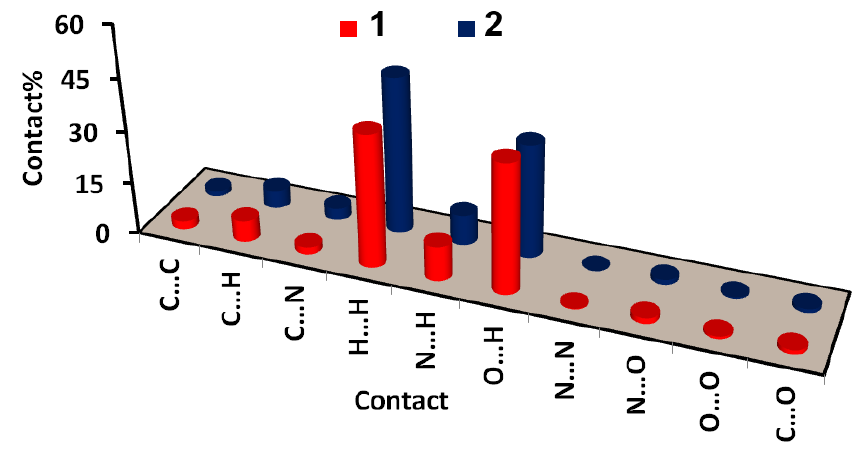
Figure 5. Summary of the intermolecular interactions in 1 and 2 .